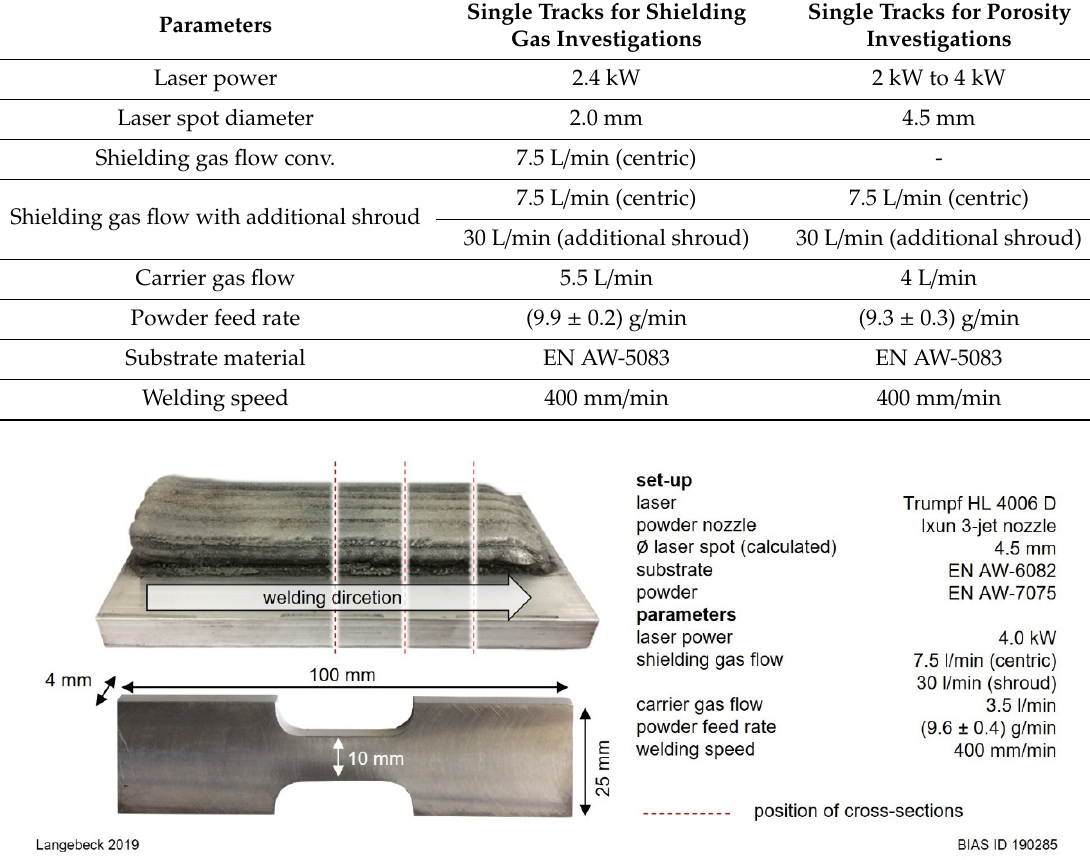
Figure 2. Additively manufactured tensile specimen with building direction parallel to load direction before and after wire-cut electrical discharge machining (EDM).